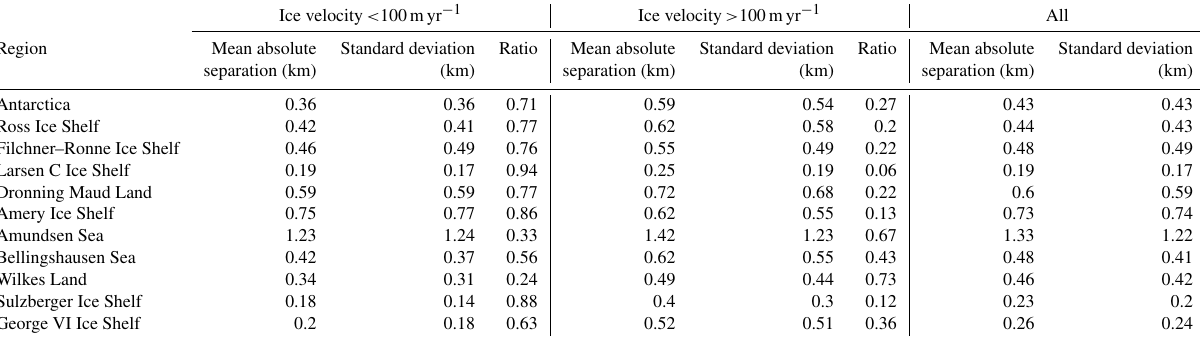
Table 3. Mean absolute separation (km) and standard deviation (km) between ICESat-2-derived break in slope (Point I b ) and ASAID break- in-slope product (Bindschadler et al., 2011) in individual regions.